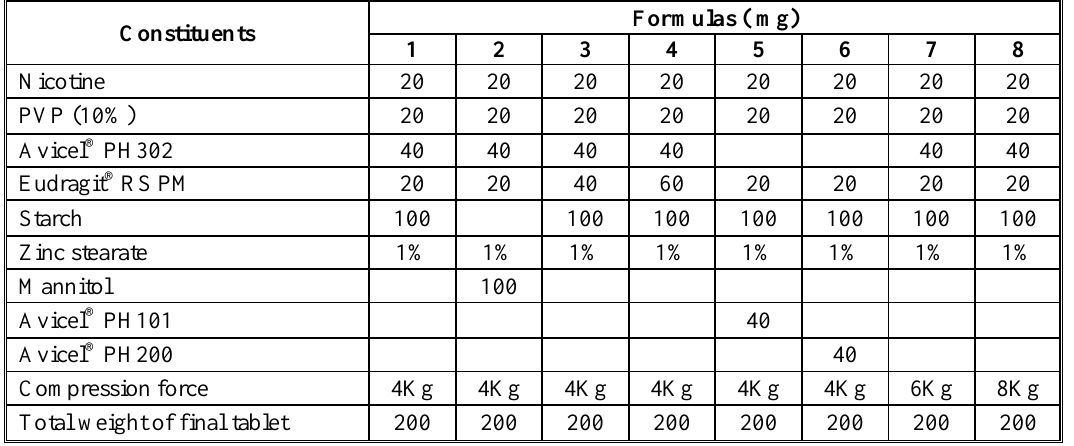
Table 1 : Different formulas of nicotine prepared as modified release